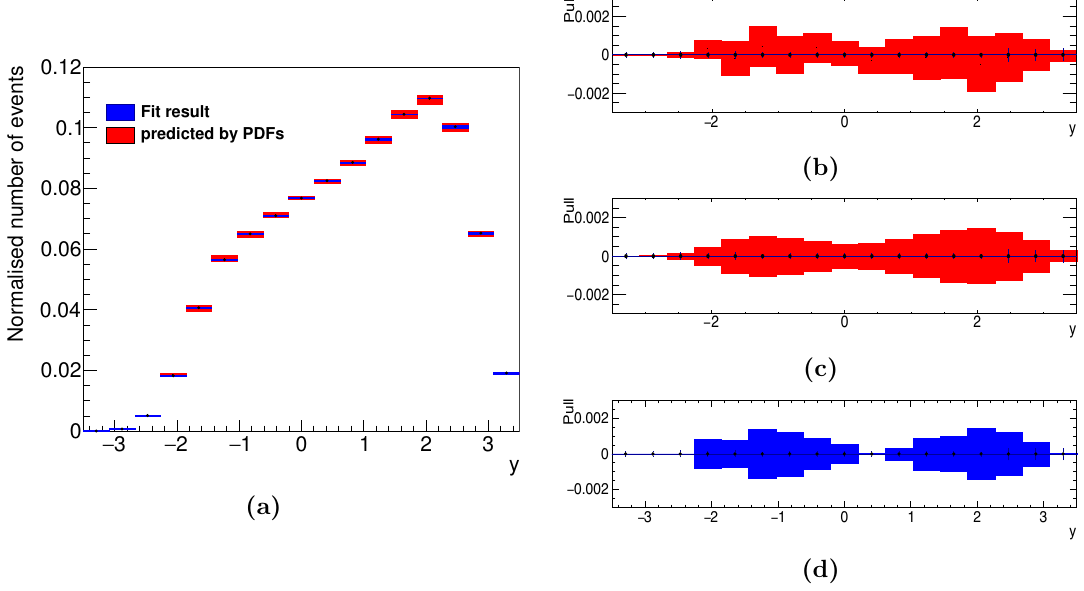
Figure 5 . a) The result of the (cid:12)t is compared to the PDFs prediction. b) Di(cid:11)erence between (cid:12)t and PDFs prediction. c) Di(cid:11)erence between (cid:12)t and PDFs prediction shifted at the same central value of the (cid:12)t. d) Shape variation when modifying the p W t